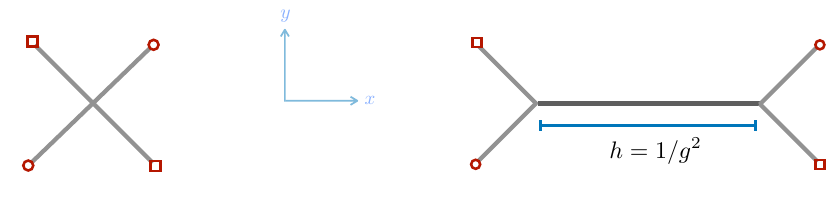
Figure 1 . On the left the brane web describing the E 1 fixed point. On the right its supersymmetric mass deformation. Segments are (p,q) 5-branes intersecting at points on the ( x, y ) plane. Their orientation is aligned with the corresponding (p,q) charges. Red circles/squares are [1,1] and [1,-1] 7-branes, respectively, which are orthogonal to the ( x, y )